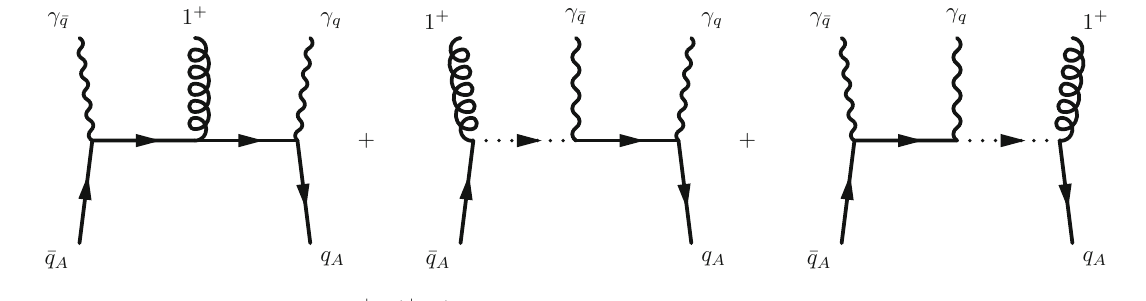
Fig. 2 Feynman diagrams contributing to A ( 1 + , ¯ q ∗+ , q ∗− )